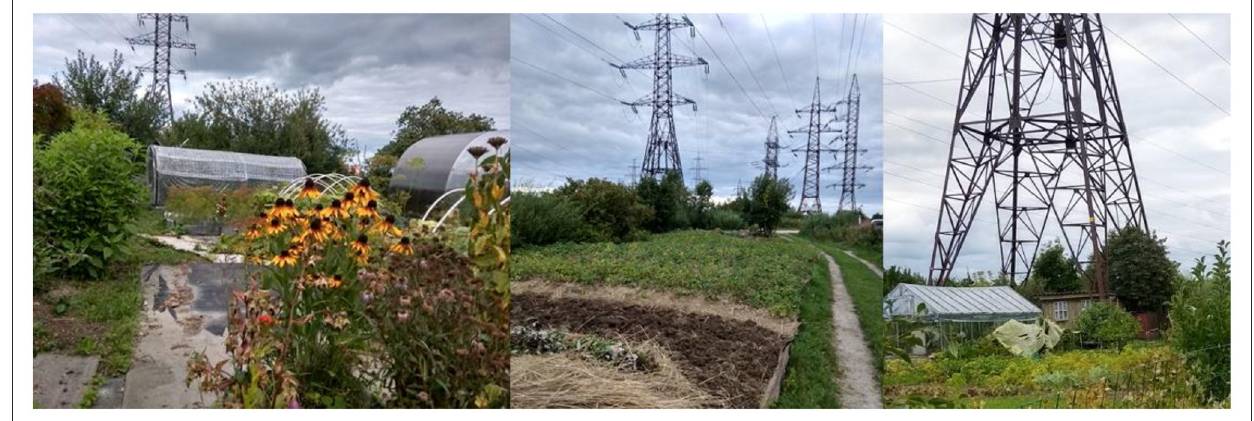
FIGURE3 Illegal dacha garden plots with green houses (left) , potato fields (middle) , and dacha allotment houses (right) in Kulgu, which have been tolerated for decades by the municipalities as well as the electricity company, which owns the land under the high voltage lines (photo by the